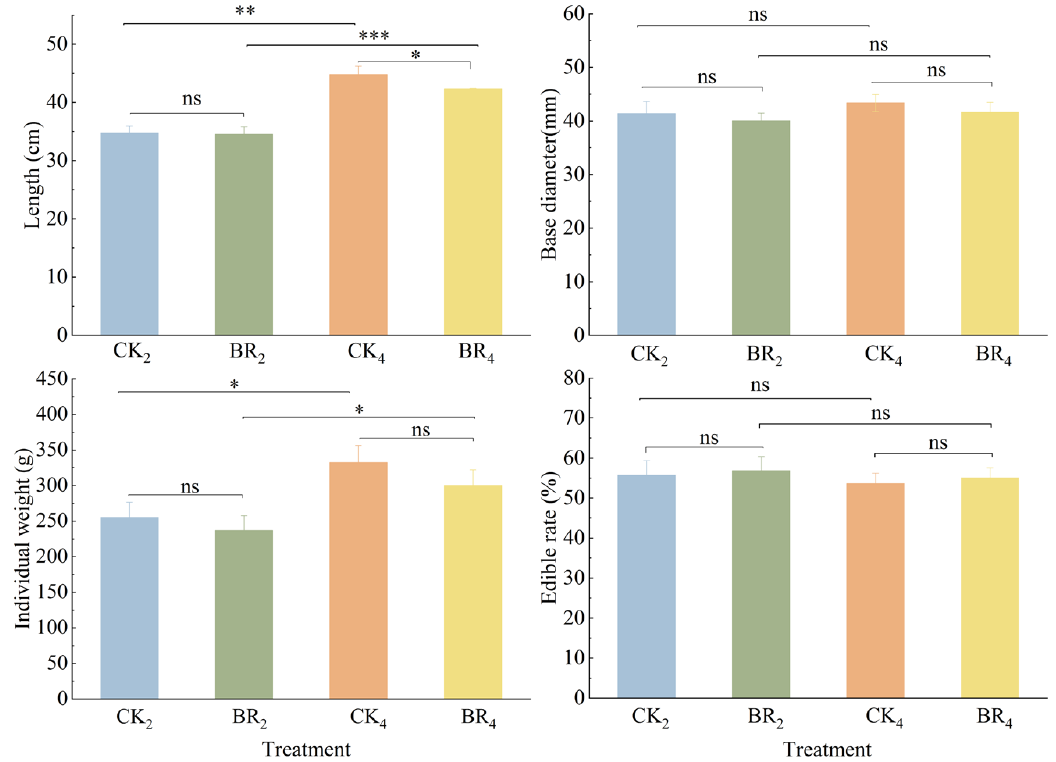
Figure 2. Morphological and edible rates after Ph. violascens sheath blade removal. CK 2 : natural growth after 2 d; BR 2 : sheath blade removal after 2 d; CK 4 : natural growth after 4 d; BR 4 : sheath blade removal after 4 d; ns: p > 0.05; *: p < 0.05; **: p < 0.01; ***: p < 0.001.